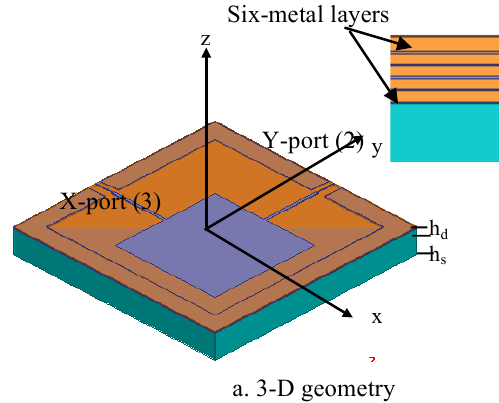
Fig.6 a. The variation of the S-parameters versus frequency for the dual-polarized microstrip patch on-chip antenna. b. The variation of gain and radiation efficiency versus frequency for the dual-polarized microstrip patch on-chip antenna.